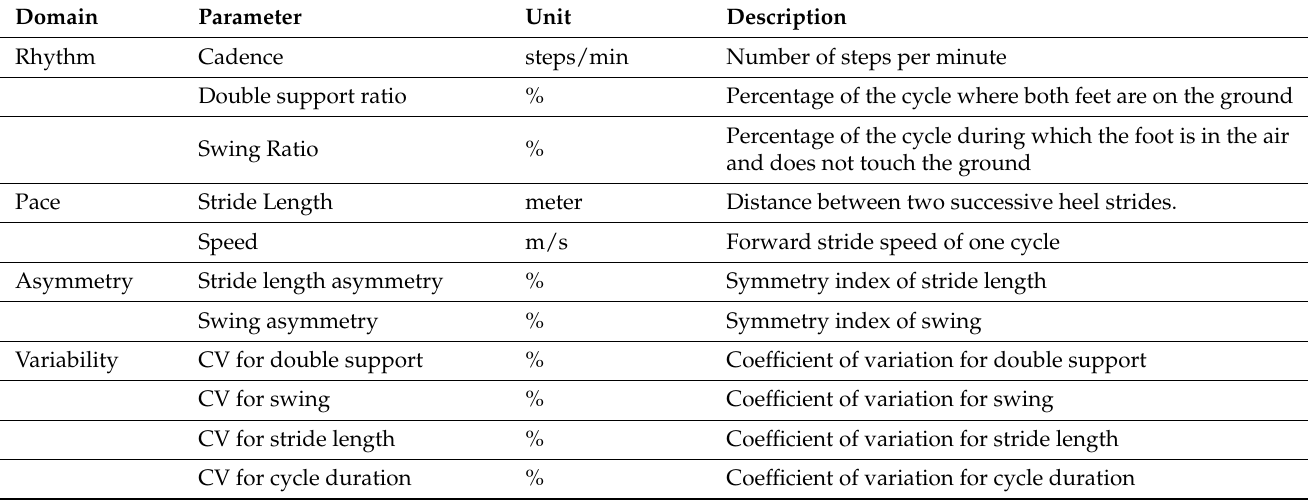
Table 1. Descriptions of the extracted spatiotemporal